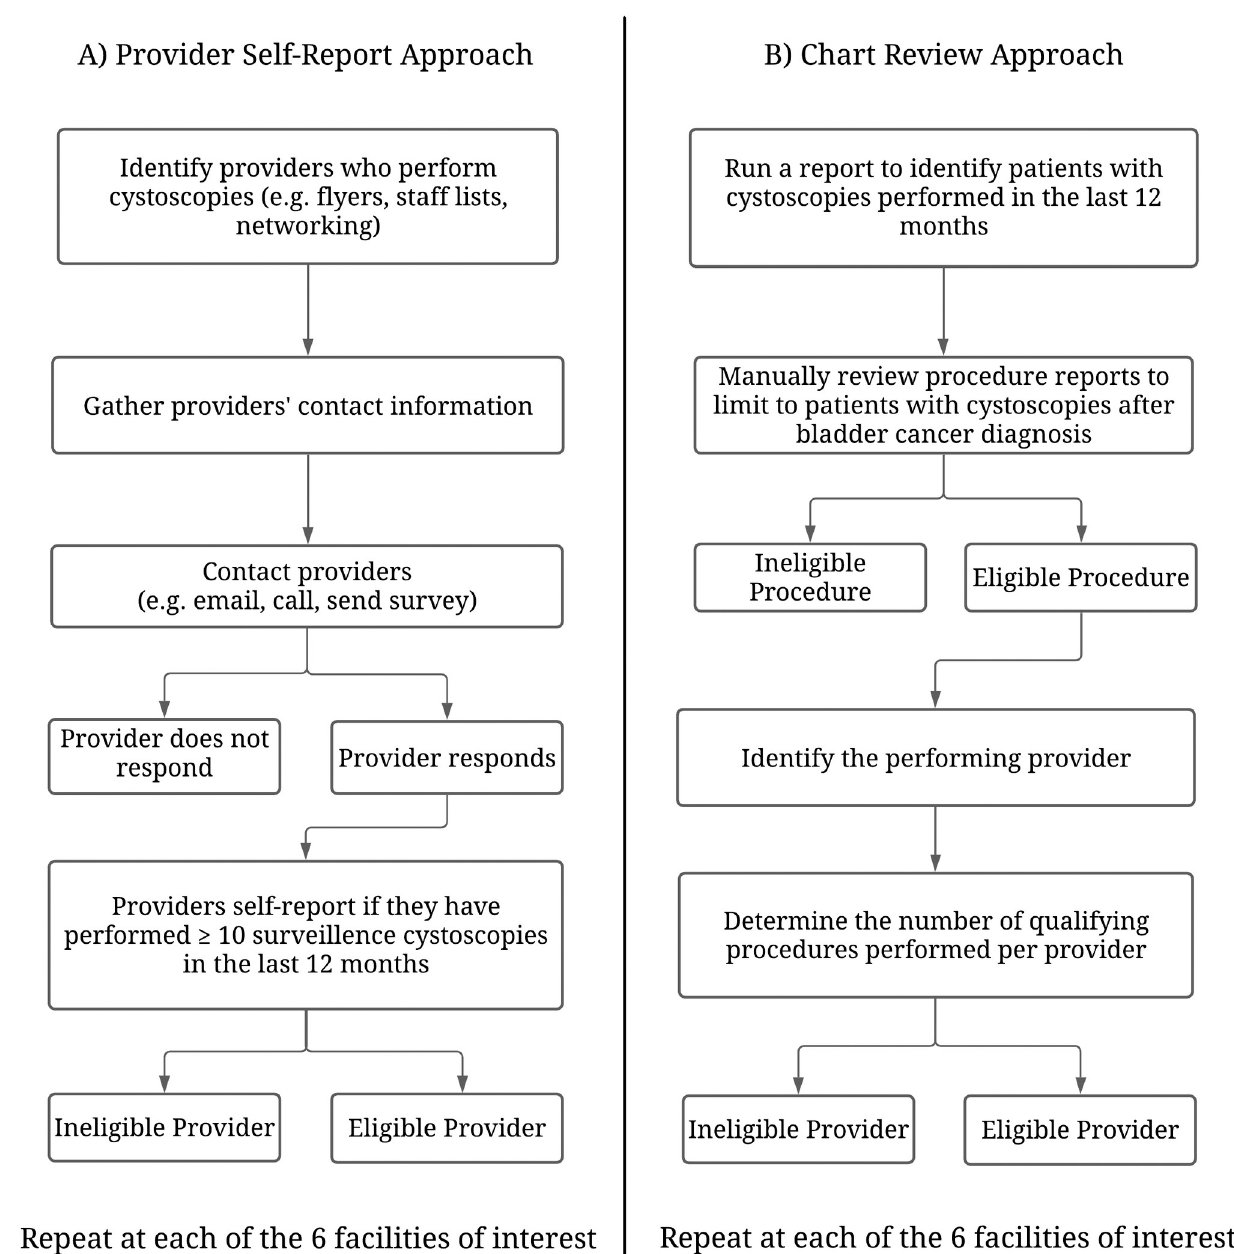
Fig 3. Flow chart of alternative approaches for identifying eligible providers: A) Provider self-reported B) Manual chart